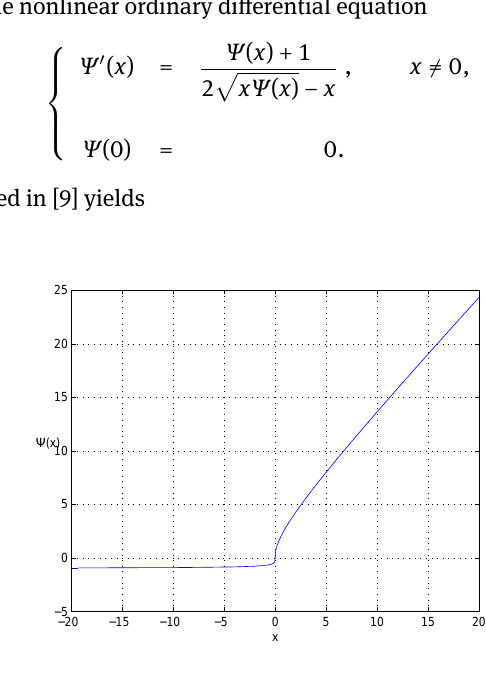
Fig. 1: Graph of the solution Ψ to the nonlinear ordinary differential equation (5)